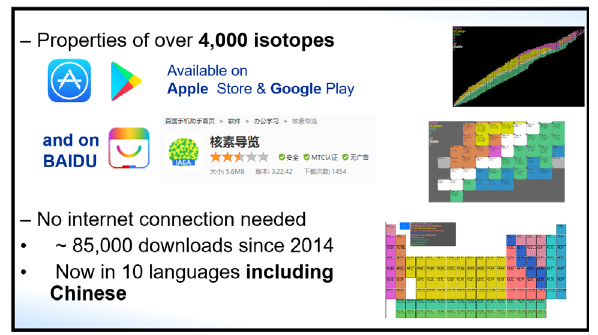
Figure 2. Isotope Browser app for mobile